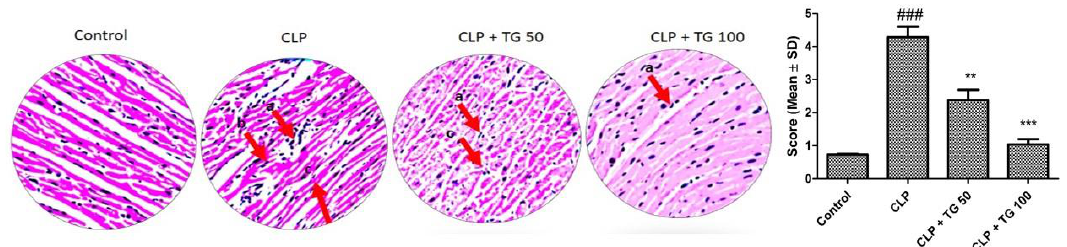
Figure 5. Effect of TG (50 and 100 mg/kg) on histological changes in the myocardial tissues at CLP-rats (hematoxylin-eosin, × 40, scale bar 5 mm= 25 µm). The pathologic are shown with arrows. Red arrows refer to CLP-induced areas in the myocardial tissues. a, myocardial cell necrosis; b, disrupted myocardial fiber; c, inflammatory cell infiltration. Values represented as means ± SD and n = 12/group. One-way analysis of variance (ANOVA), followed by Tukey’s test were used for statically analysis. Where ### p < 0.001 when compared to control group, whereas ** p < 0.01 and *** p < 0.001 when compared CLP group animals.